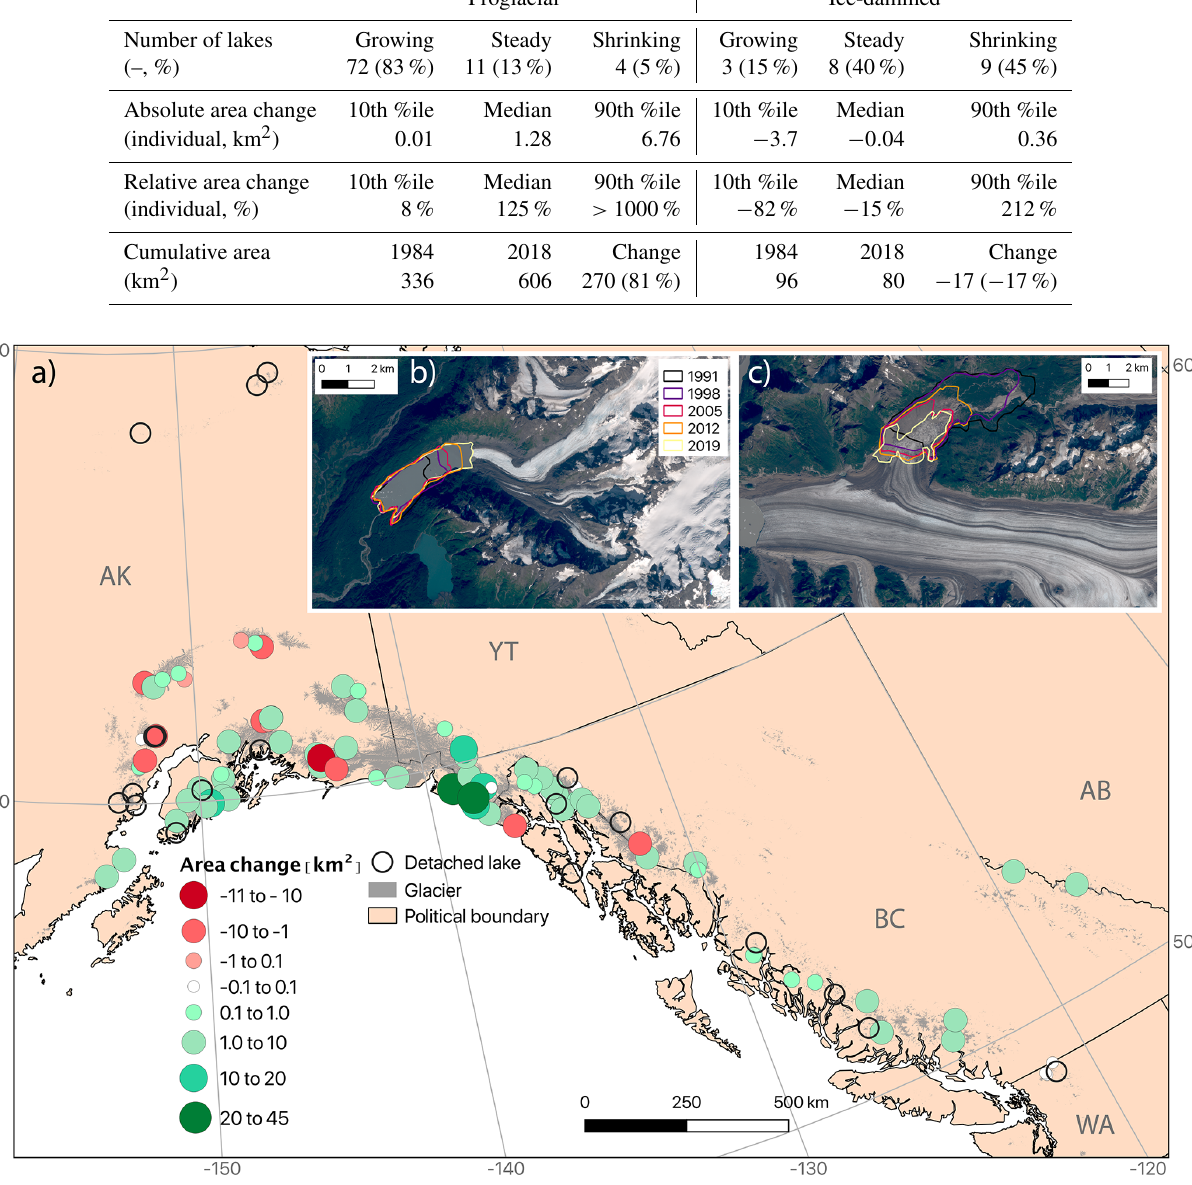
Table 2. Summary statistics for proglacial and ice-dammed study lake area change. Steady lakes are defined as having changed by less than ± 0 . 1km 2 . Summary statistics are shown for the change in individual lakes, as well as for the cumulative area of all study lakes. For descriptors of individual lakes, we use the robust statistics of the median and 10th- and 90th-percentile lake area change because the existence of extreme values makes the minimum, mean, and maximum area change less meaningful (%ile denotes percentile in the table). Relative area change is scaled by a lake’s initial area, so a 100% increase indicates a lake that doubled in area, while − 100% indicates a lake that completely disappeared.